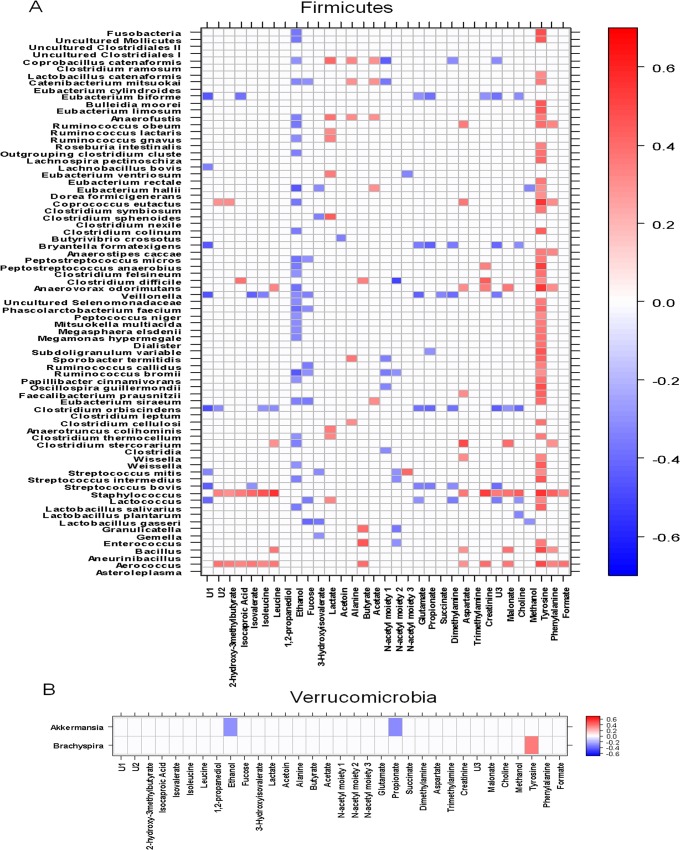
Correlation heat-map between OTUs and faecal metabolites.Significant correlations (p<0.05) for Firmicutes (Panel A) and Verrucomicrobia (Panel B). 2OH3MB: 2-hydroxy-3-methylbutyrate; Isocapr: Isocaproate; Isoval: Isovalerate; Ile: Isoleucine; Leu: Leucine; EtOH: Ethanol; Fuc: Fucose; 3OH-Isoval: 3-hydroxyisovalerate; Lac: Lactate; Ala: Alanine; But: Butyrate; Ac: Acetate; N-Ac: N-Acetyl moiety; Glu: Glutamate; Suc: Succinate; DMA: Dimethylamine; Asp: Aspartate; TMA: Trimethylamine; Cr: Creatine; MA: Malonate; Cho: choline; MeOH: Methanol; Tyr: Tyrosine; Phe: Phenylalanine; For: Formate.